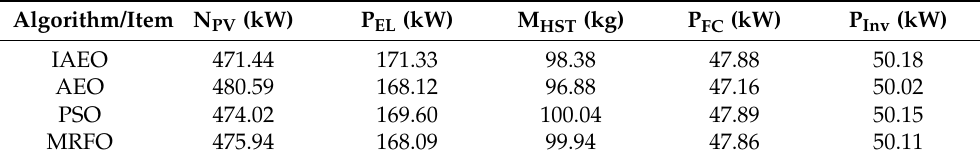
Table 3. Statistical analysis for different algorithms in the sizing of the HPV/FC energy system considering ENSP max = 1%.